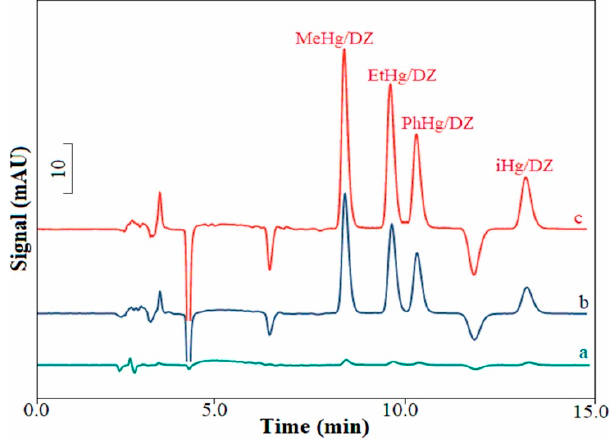
Figure 4. Chromatograms of studied mercury species before treatment with in-tube SPME (a), after treatment with in-tube SPME-HPLC-DAD (b) and treatment with magnetic-field-reinforced in-tube SPME-HPLC-DAD (c) from reference [26].